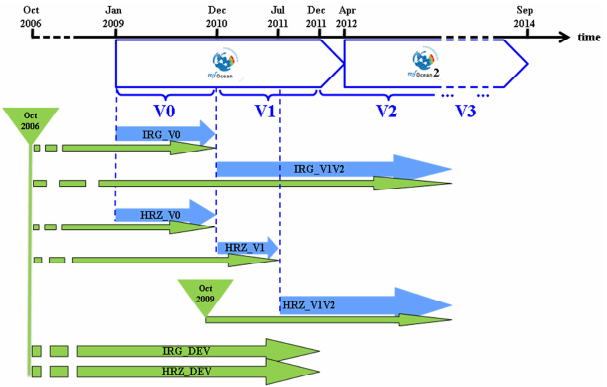
Fig. 1. Timeline of the MyOcean global analysis and forecasting system for the various milestones V0, V1 and V2. Real-time MyOcean production is in blue. Available Mercator Océan simulation is in green including the catch-up to real-time. The latest most advanced versions of systems in terms of scientific developments are named IRG_DEV and HRZ_DEV for intermediate resolution global and high resolution zoom systems respectively.